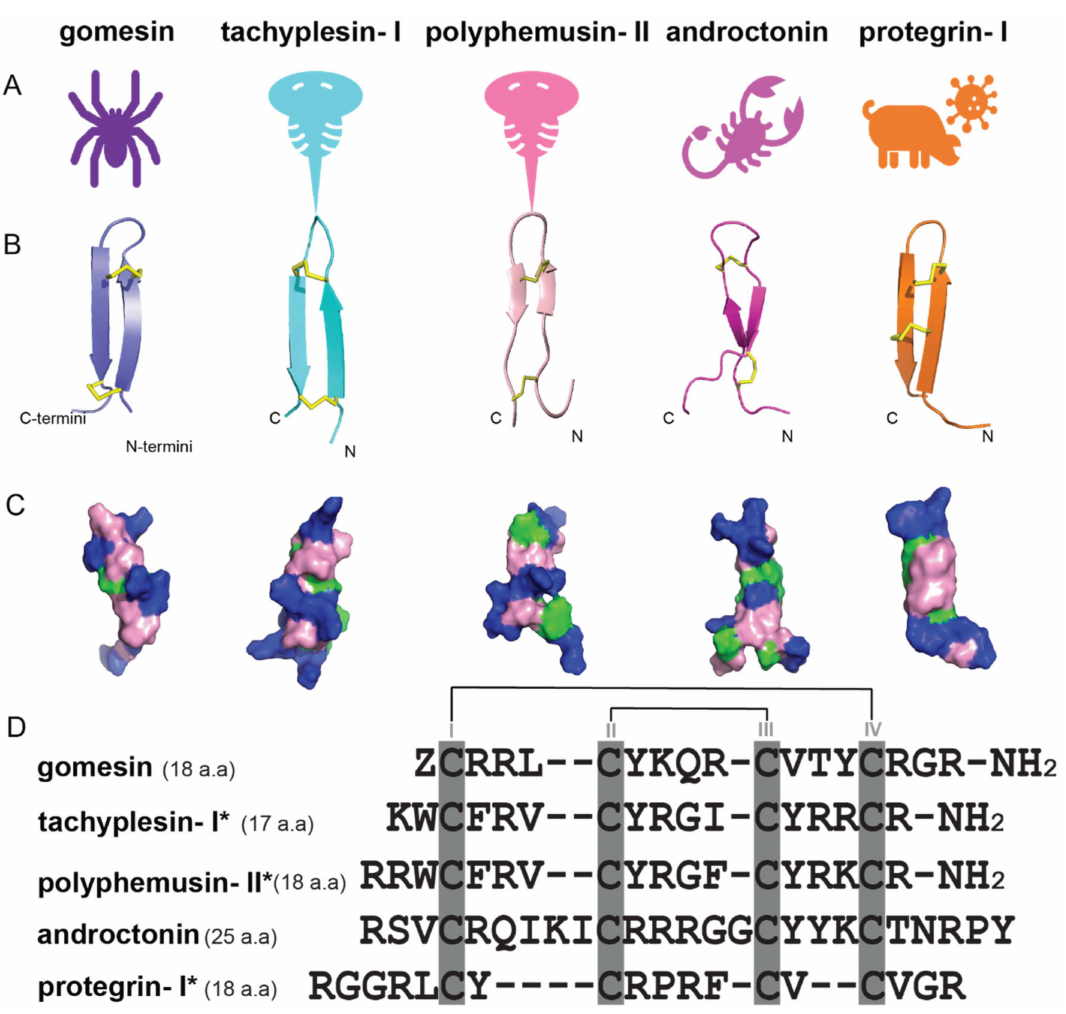
Figure 4. Structures and sequence alignment of β -hairpin AMPs. ( A ) Natural sources from which listed peptides were first identified: gomesin was isolated from the spider Acanthoscurria gomesiana ; tachyplesin-I from the horseshoe crab Tachypleus tridentatus ; polyphemusin-II from the horseshoe crab Limulus polyphemus ; androctonin from the scorpion Androctonus australis ; protegrin-I from the porcine leukocytes ( Sus domesticus ). ( B ) Ribbon representation of the β -hairpin-like structure of Gm (PDB ID: 1KFP), tachyplesin (PDB ID: 2RTV), polyphemusin (PDB ID: 1RKK), androctonin (PDB ID: 1CZ6), and protegrin (PDB ID: 1PG1). Disulfide bonds are represented as yellow sticks. ( C ) Surface representations of Gm, tachyplesin-I, polyphemusin-II, androctonin, and protegrin-I. Non-polar (hydrophobic), polar, and positively charged residues are shown in green, pink, and blue, respectively. ( D ) Sequence alignment and total amino acid (a.a) content of Gm, tachyplesin-I, polyphemusin-II, androctonin, and protegrin-I. Cysteine residues are highlighted by a grey box, and disulfide bond connectivities (Cys I-IV, and Cys II-III) are shown in thick black lines. *: There is more than one variant of this peptide